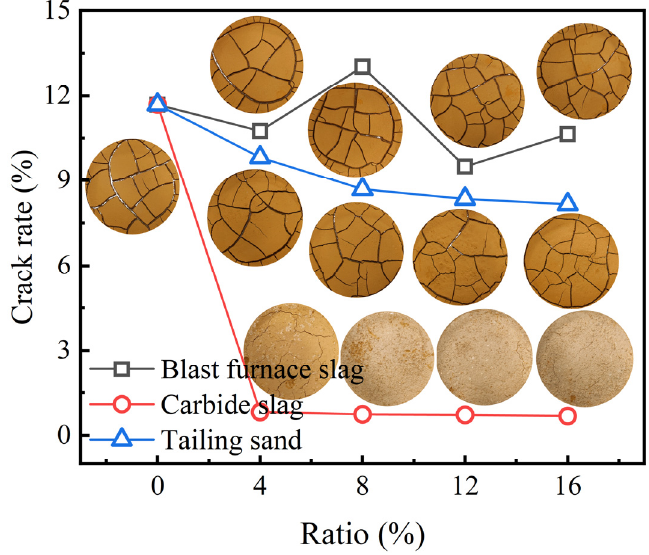
Figure 9. Crack rate of different waste residues soils.